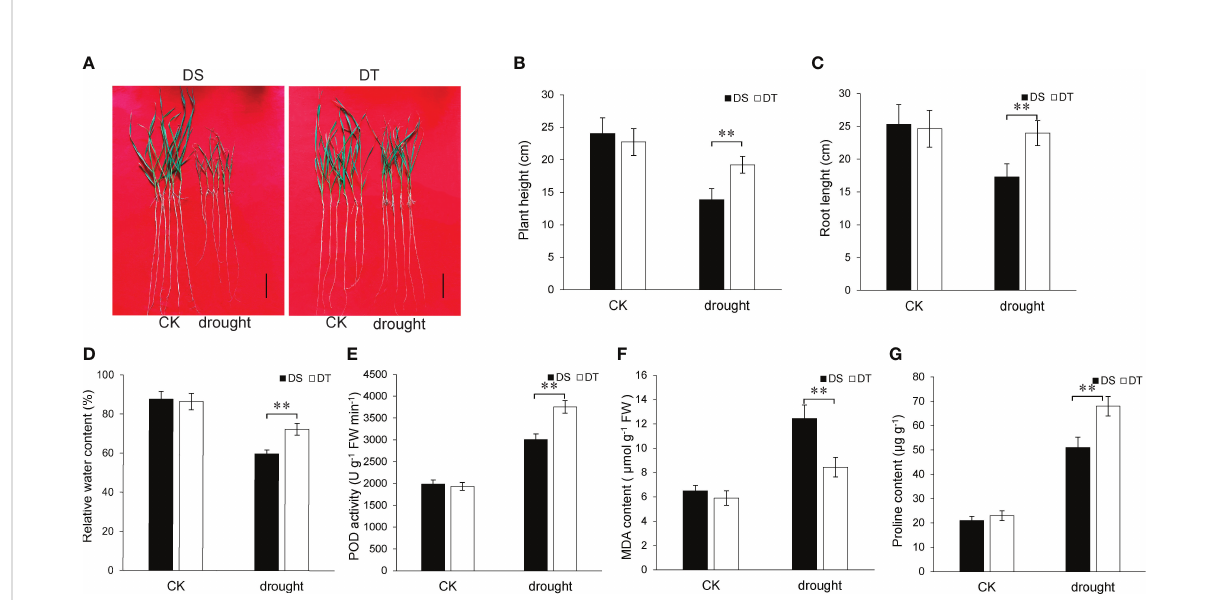
FIGURE 1 Phenotypes of the two wheat varieties under drought stress and control conditions. (A) Phenotypes of the two wheat varieties at the seedling stage under drought stress and control conditions for seven days. DS, drought-sensitive variety JM38, DT, drought-tolerant variety ZM13; Scale bars, 5 cm. (B) Height of plants subjected to drought stress for seven days. Values are means ± SD. ** P < 0.01. (C) Root length in plants subjected to drought stress for seven days. (D) Relative water content of plant leaves subjected to drought stress for four days. (E) Peroxidase activity of plant leaves subjected to drought stress for four days. (F) Malindialdehyde content of plant leaves subjected to drought stress for four days. (G) Proline content of plant leaves subjected to drought stress for four